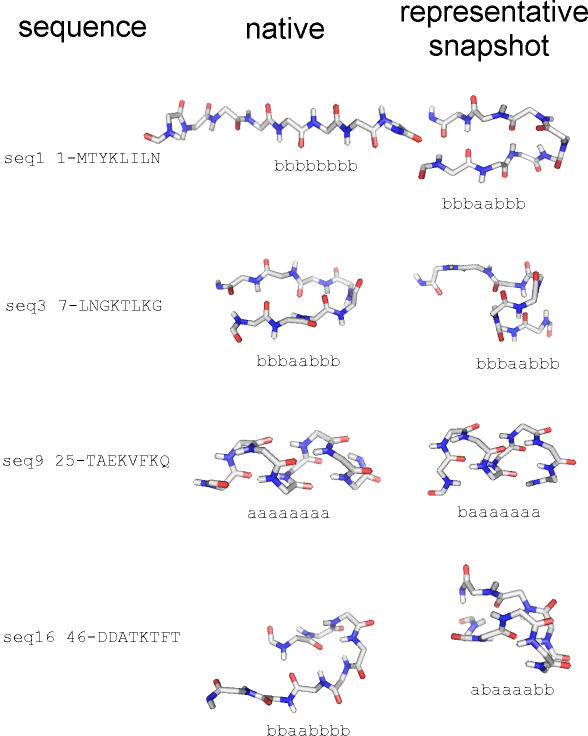
Representative Snapshots of Various Peptides from Protein GThe representative snapshot is the snapshot in the ground mesostring with the lowest energy. The ground mesostring of seq1 and seq3 are classed as reverse-turns, and the ground mesostring of seq9 and seq16 are classed as helical-turns.